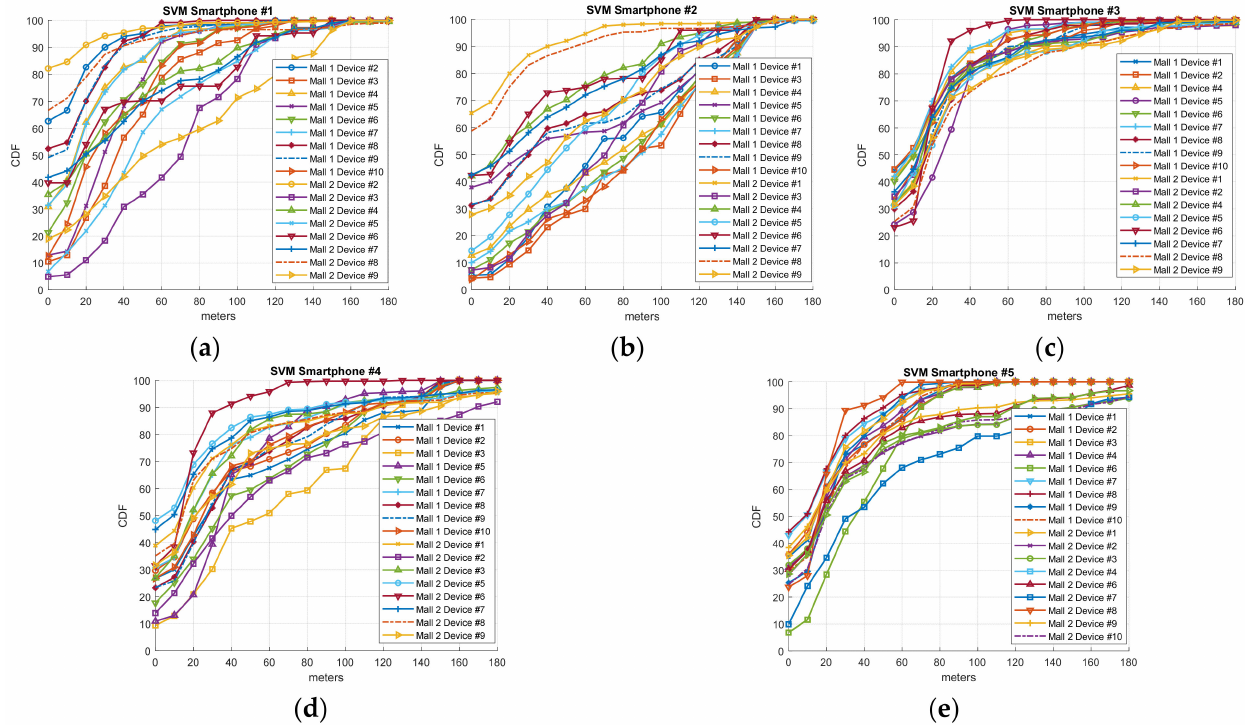
Figure 9. CDF referring to the accuracy of the IPS generated with SVM on day 74 for mall #1 and day 60 for mall #2 employing smartphones ( a ) #1, ( b ) #2, ( c ) #3, ( d ) #4, and ( e )